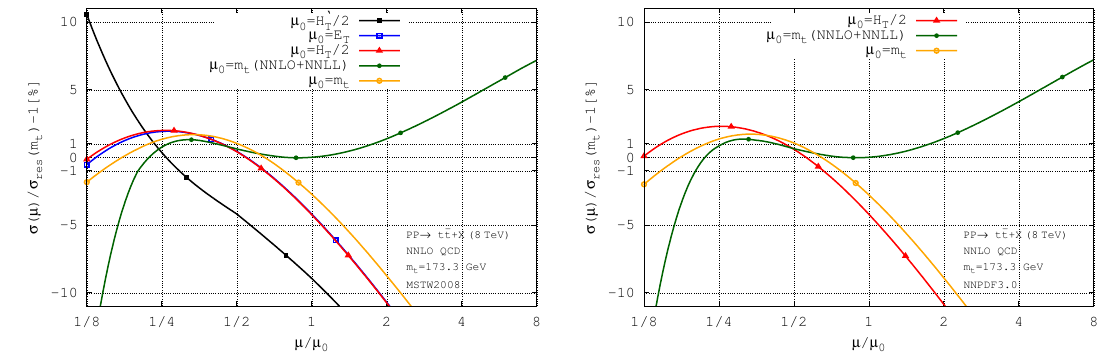
Figure 4 . Comparison of the total cross-section at NNLO evaluated with di(cid:11)erent dynamic scales and with two di(cid:11)erent pdf sets: MSTW2008NNLO (left) and NNPDF3.0NNLO (right). The sym- bols on some of the lines are meant to help distinguish the various